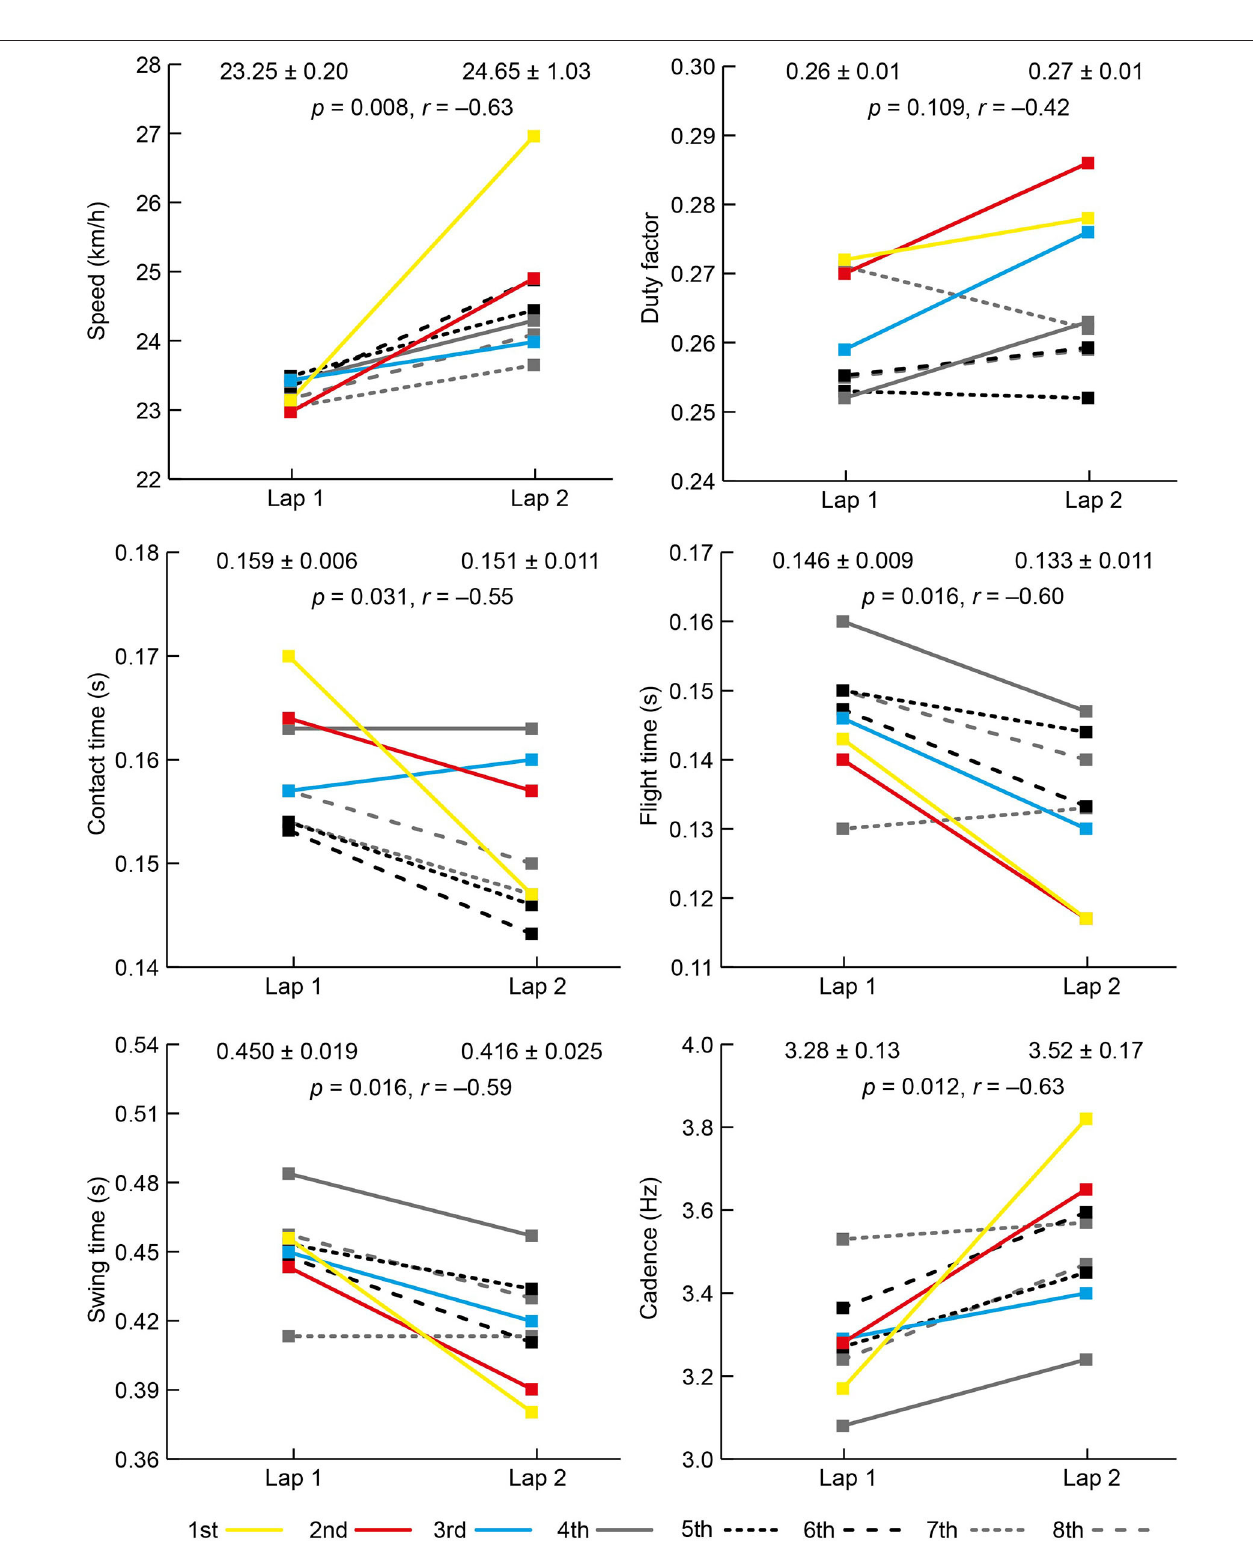
FIGURE 2 | Mean ( ± SD) and individual athlete data for speed and temporal data on laps 1 and 2 of the women’s 800m final. The color used to represent each athlete is the same for each variable and the key for finishing positions is shown at the bottom of the figure.